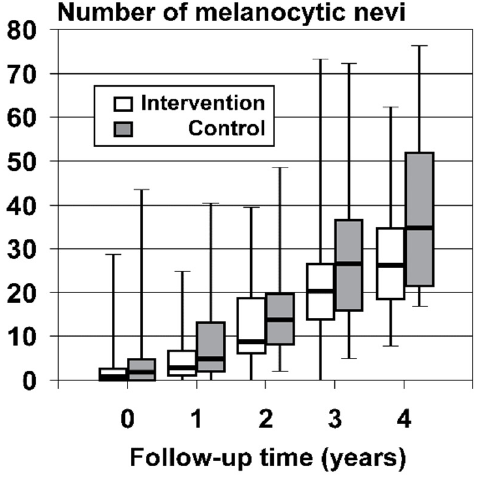
Figure 2. Total number of new melanocytic nevi developed by 1–35-month-old children participat- ing in a cluster randomized controlled trial of sun-protective clothing in children attending a par- ticipating childcare center in Townsville,